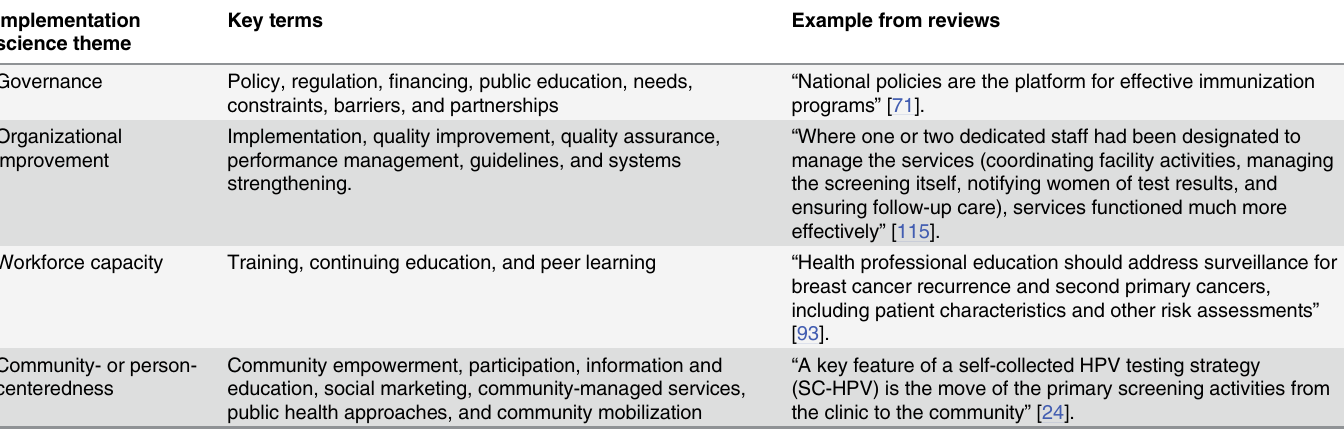
Table 1. Implementation science